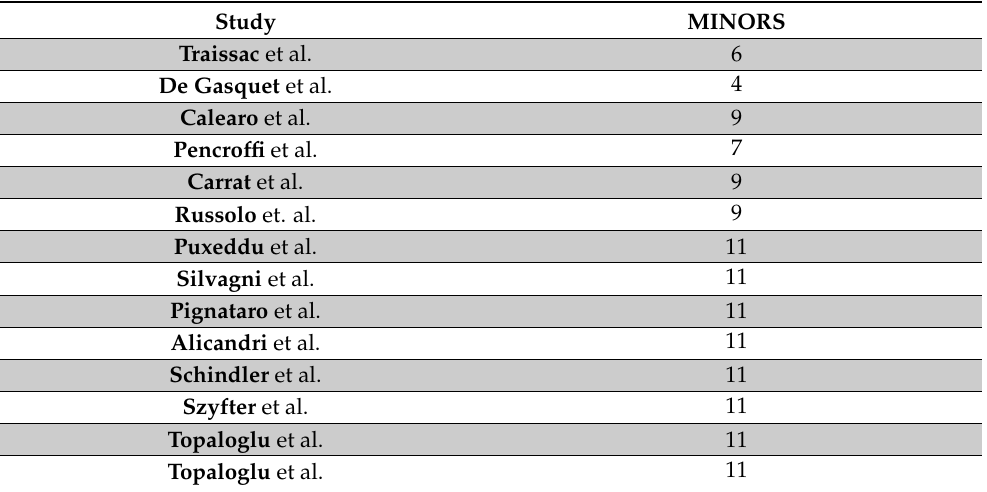
Table 2. Assessment of quality and risk of bias. MINORS: Methodological Index for Non- Randomized